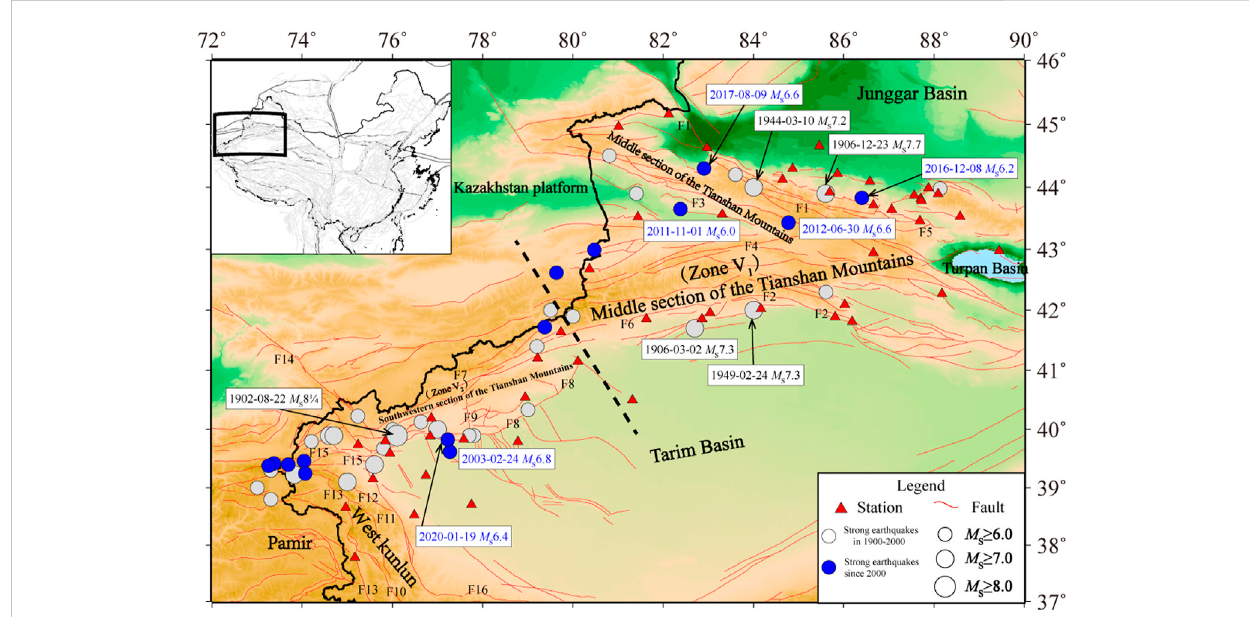
FIGURE 1 Map illustrating the Tianshan tectonic belt (TTB) and its adjacent tectonic units, along with the geographical distributions of the historical earthquakesandseismicobservationstationsintheregion.TheearthquakeshavingMs ≥ 6.5thatoccurredbetween1900and2000areindicatedbygray circles,whiletheearthquakesofMs ≥ 6.0thatoccurredafter2000areindicatedbybluecircles.Thedottedlinerepresentstheborderbetweenthemiddle and southwestern TTB. F1: Borohoro ‒ Aqikekuduke fault; F2: Beiluntai fault; F3: Northern Ili Basin margin (Kashi River) fault; F4: Nalati fault; F5: Yilianhabierga fault; F6: Kumugeremu fault; F7: Maidan ‒ Shayilamu fault; F8: Kalpintag fault; F9: Piqiang fault; F10: Kangxiwa fault; F11: Kongur fault; F12: Oytak fault; F13: Karakoram fault; F14: Talas ‒ Fergana fault; F15: Kazkeaerte fault; F16: Tiklik